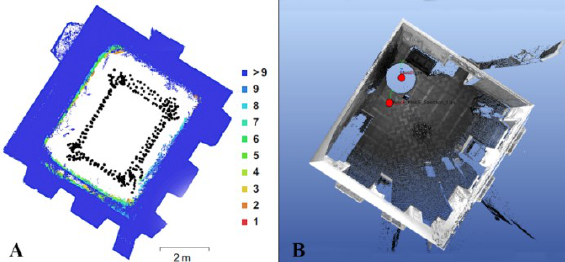
Figure 3. The sketch of A) Image distribution, B) TLS positions 4.